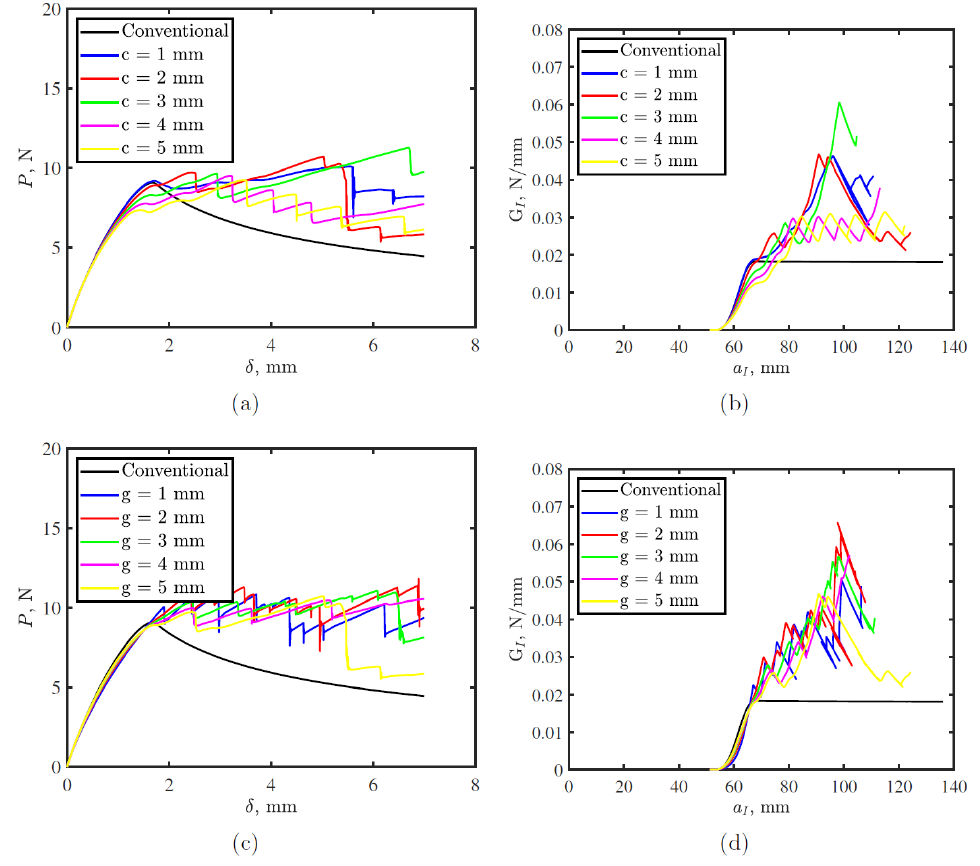
Figure 7. Double cantilever beam (DCB) simulation crack width, c and gap between two successive cracks, g effects on, ( a , c ) load-displacement; and ( b , d ) R-curve,